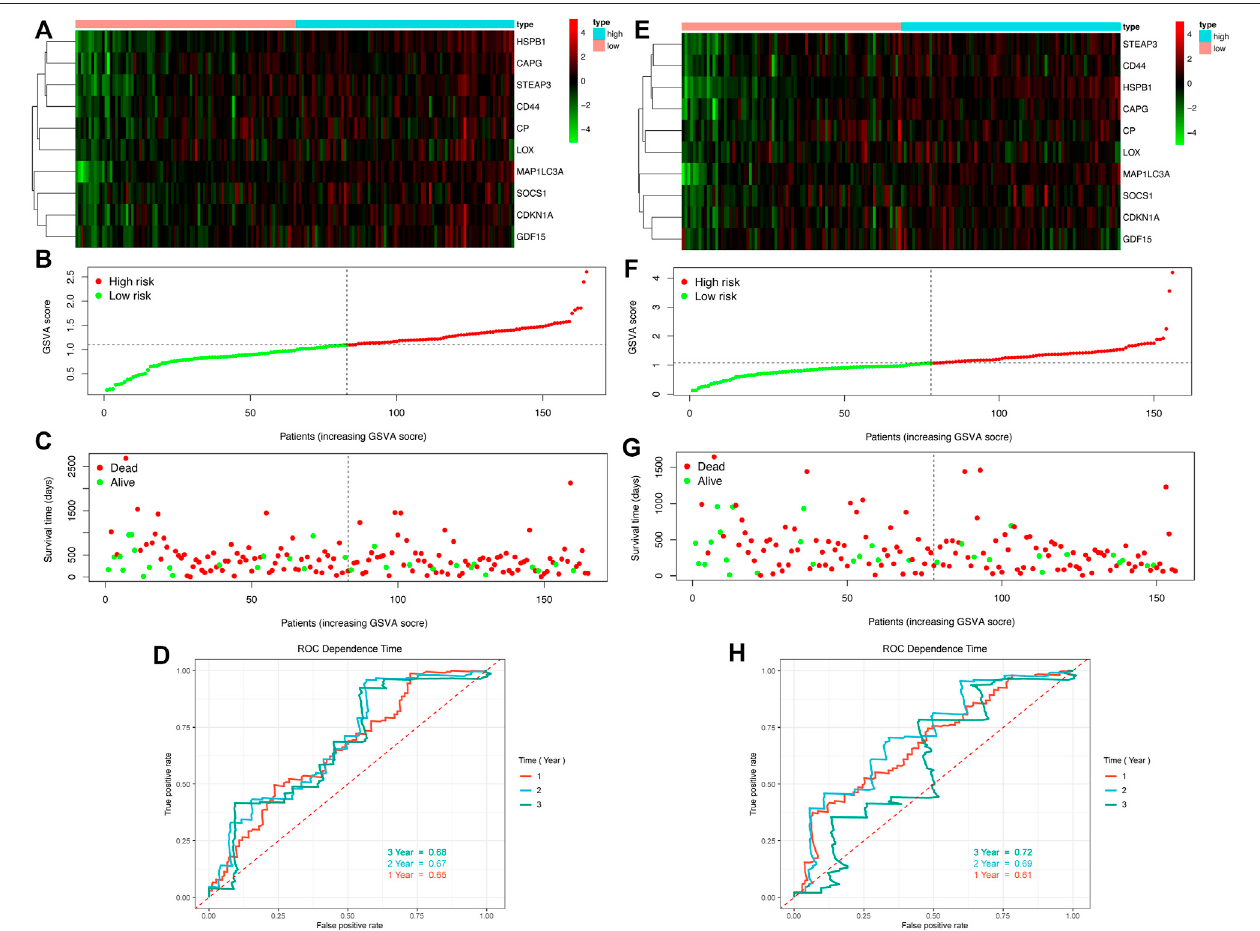
FIGURE 7 | Growth of GSVA score of GBM patients is associated with increased mortality and decreased survival time (A – D) OS (E – H) RFS (A,E) Heat maps of key genes expression pro fi les (B – C,F – G) Distribution of risk scores, patient survival times and status (D,H) ROC curves.